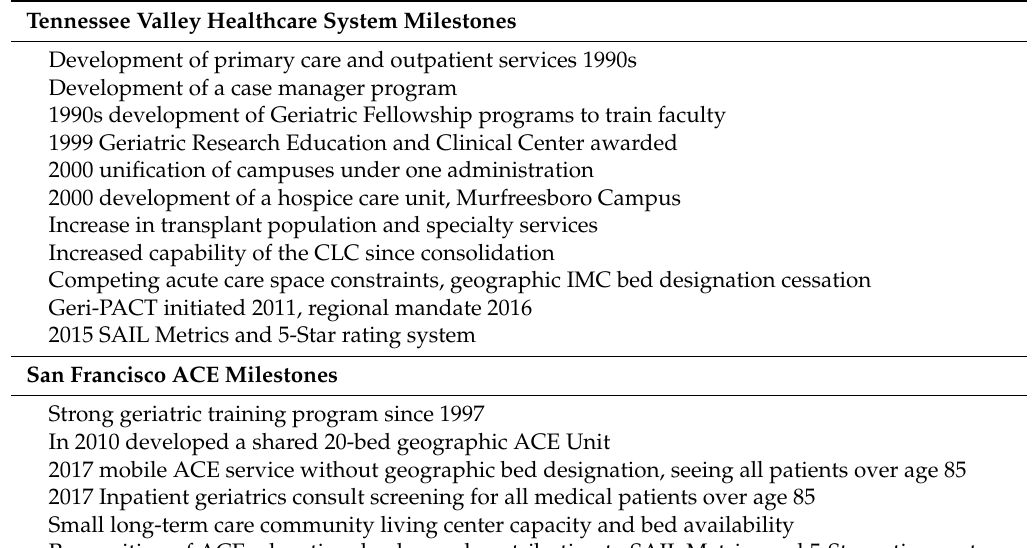
Table 2. Developmental program